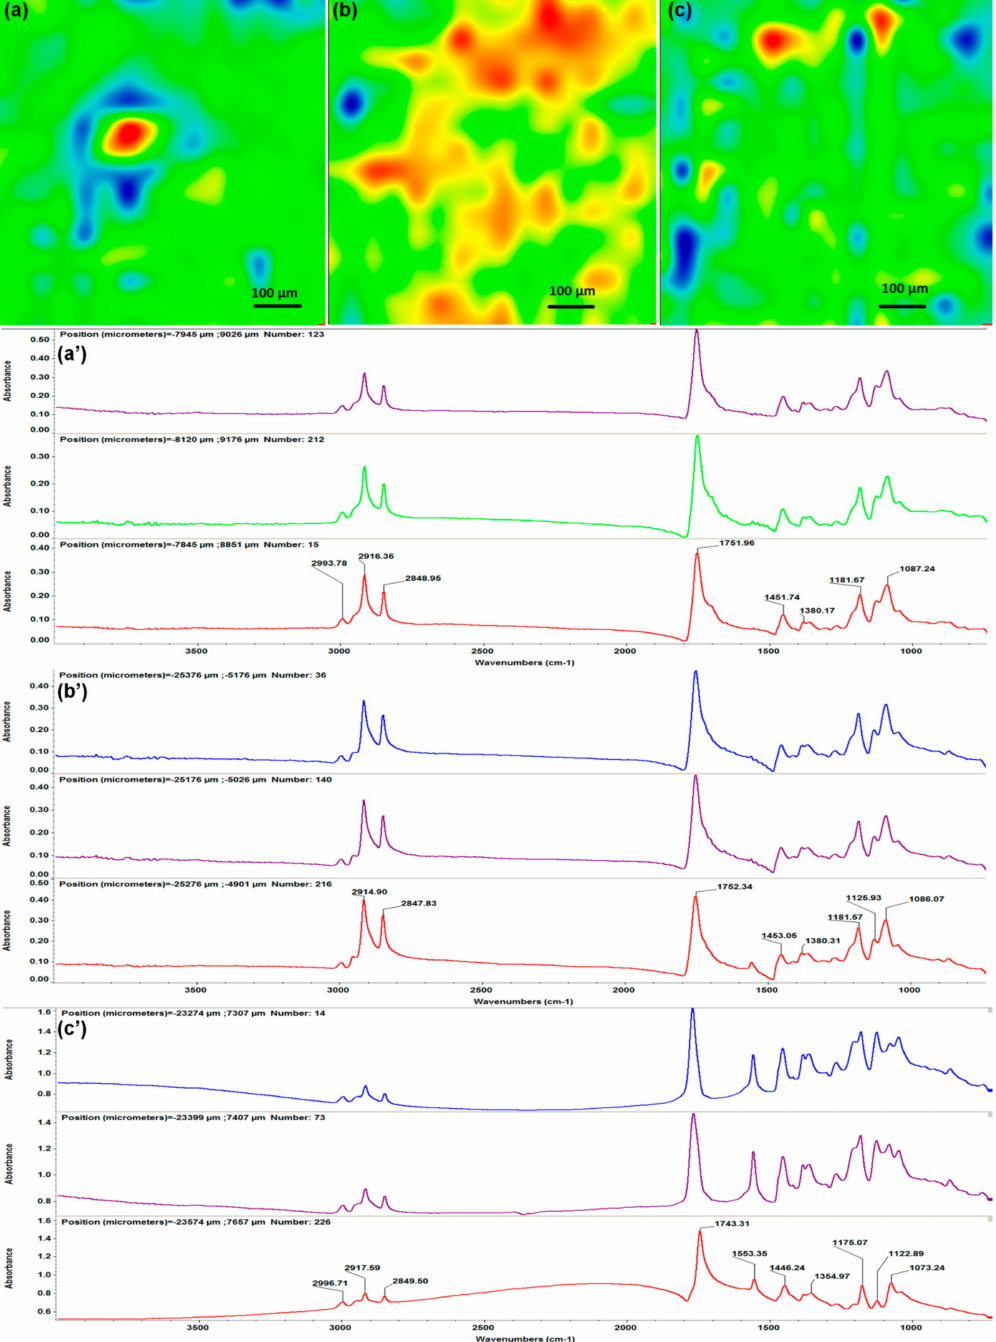
Figure 4. IR maps ( a – c ) and IR spectra ( a’ – c’ ) of PLA / AgNPs coatings obtained at laser fluences of 300 mJ / cm 2 ( a , a’ ), 400 mJ / cm 2 ( b , b’ ) and 500 mJ / cm 2 ( c , c